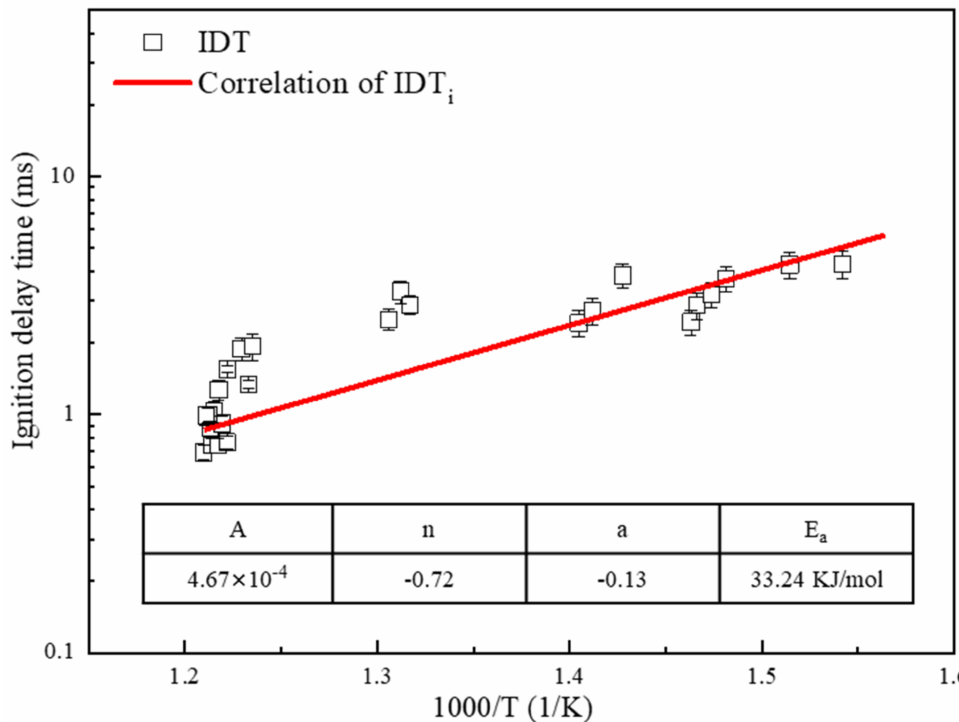
Figure 12. IDT correlation of ignited tests for RP-3 kerosene